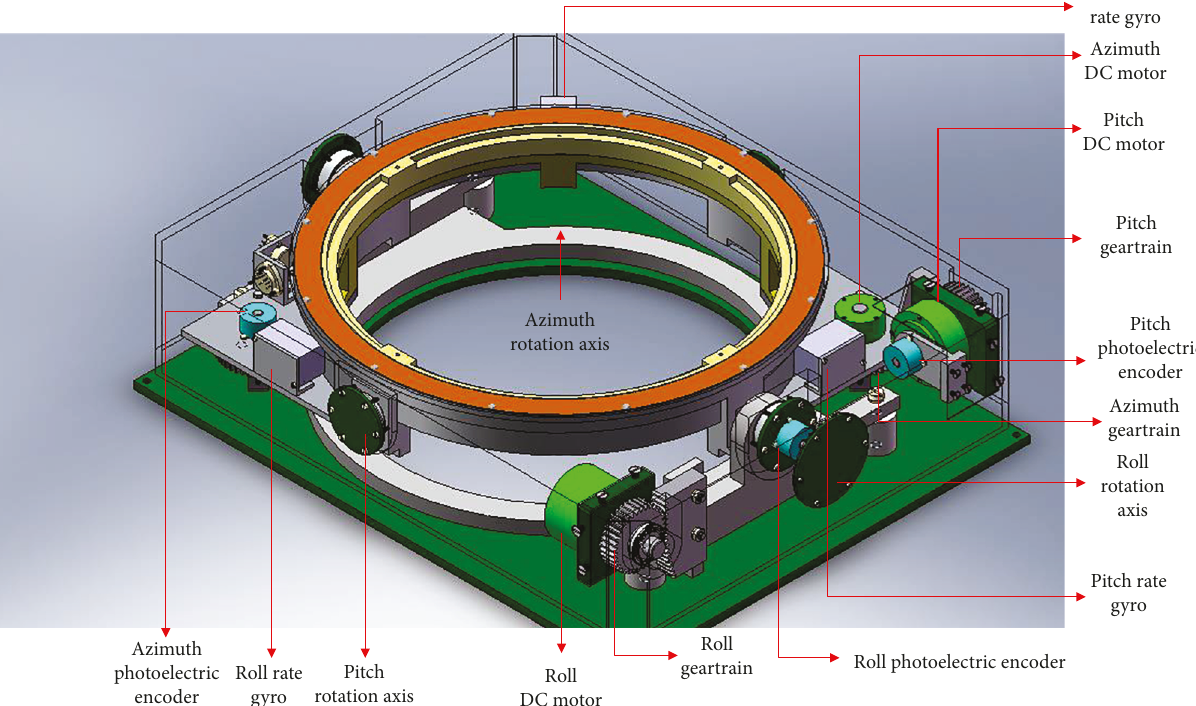
Figure 2: Schematic diagram of the three-axis ISP.